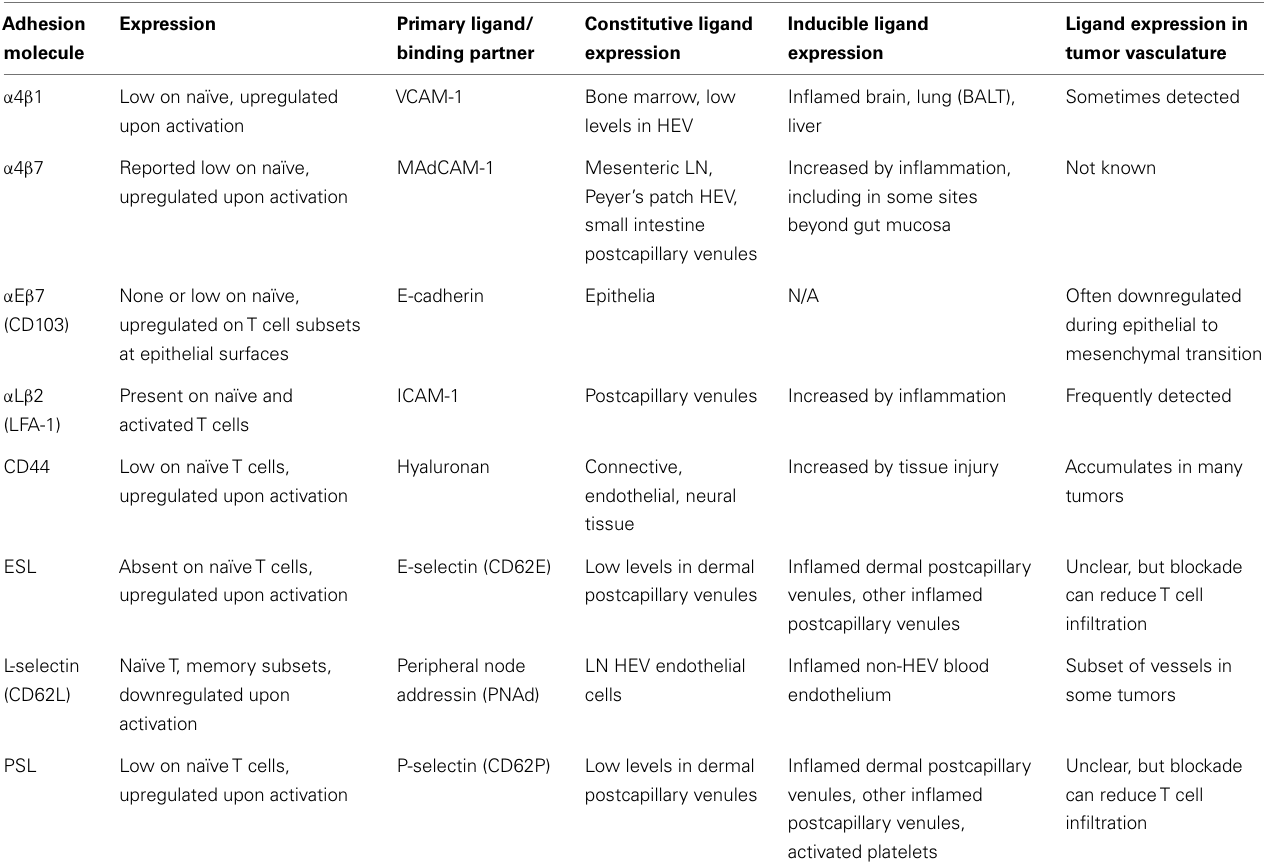
Table 1 |Adhesion molecules expressed by murine CD8T